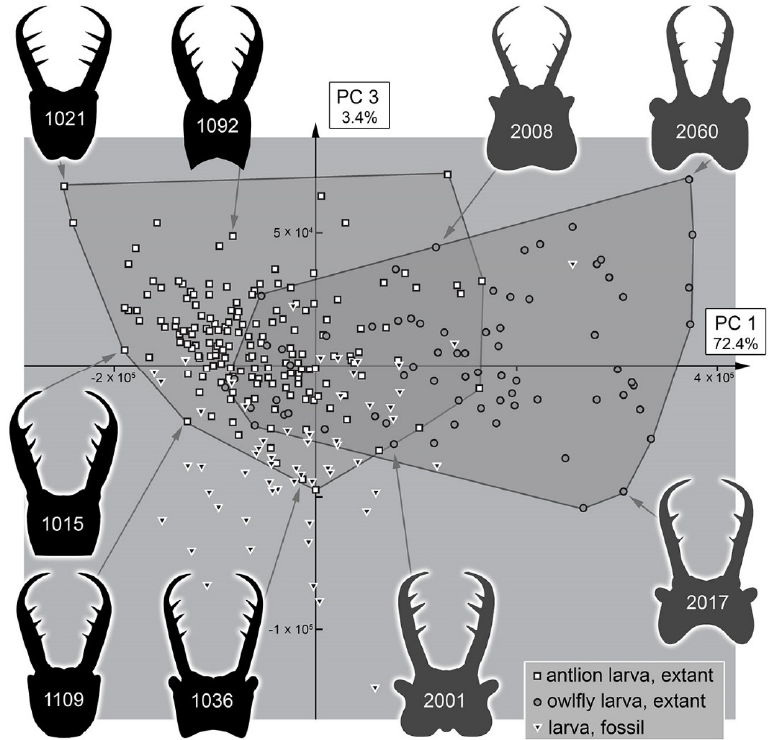
Figure 39. Scatterplot of PC3 vs. PC1 values of head shapes of all specimens. Black heads = antlion larvae; grey heads = owlfly larvae.